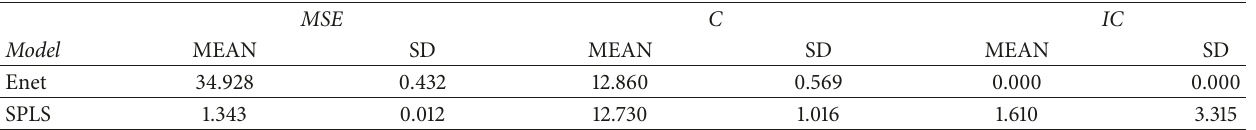
Table 2: Model selection and fitting results based on 100 replications in studying of multicollinearity. “MEAN” and “SD” denote mean and standard deviation, respectively. MSE C